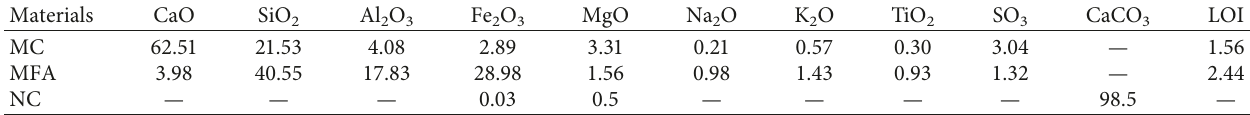
Table 1: Chemical compositions of MC, MFA, and NC (wt.%).